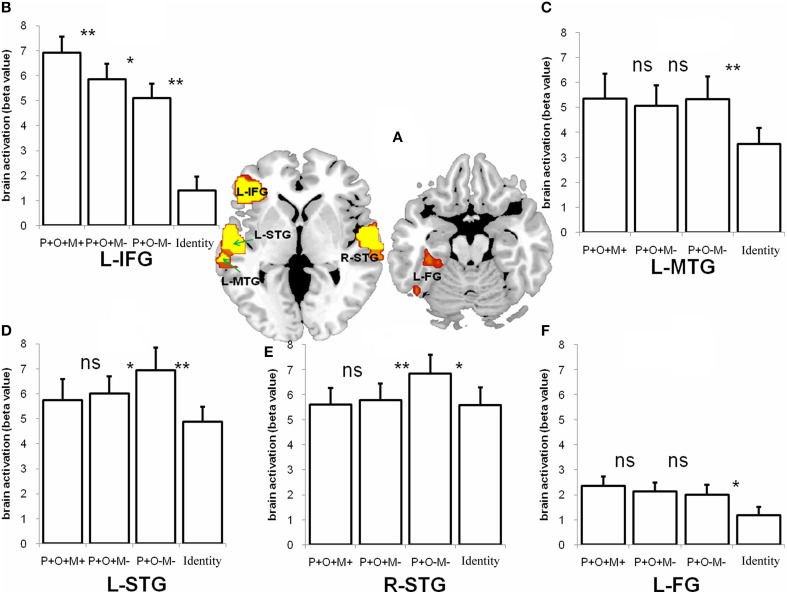
The conjunction activation of the P+O+M+, the P+O+M-, and the P+O-M- during morphological processing and the retest of these ROIs in the Identical condition. (A) The five regions including the L-IFG, the L-MTG, the L-STG, the R-STG, and the L-FG were significantly activated in the conjunction analysis (p < 0.05, cluster size corrected) during morphological processing (B–F). The retests of these conjunctional regions in the four conditions (the P+O+M+, the P+O+M-, the P+O-M-, and the Identical condition). ns, non significant; **p < 0.01; *p < 0.05.